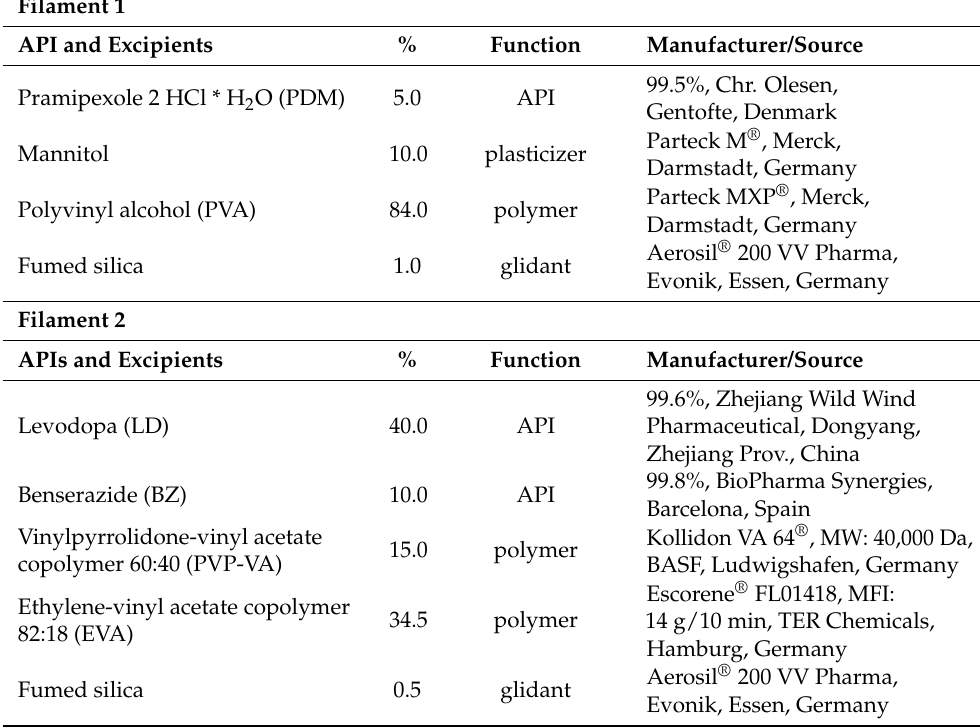
Table 2. Formulations used for the polypill.